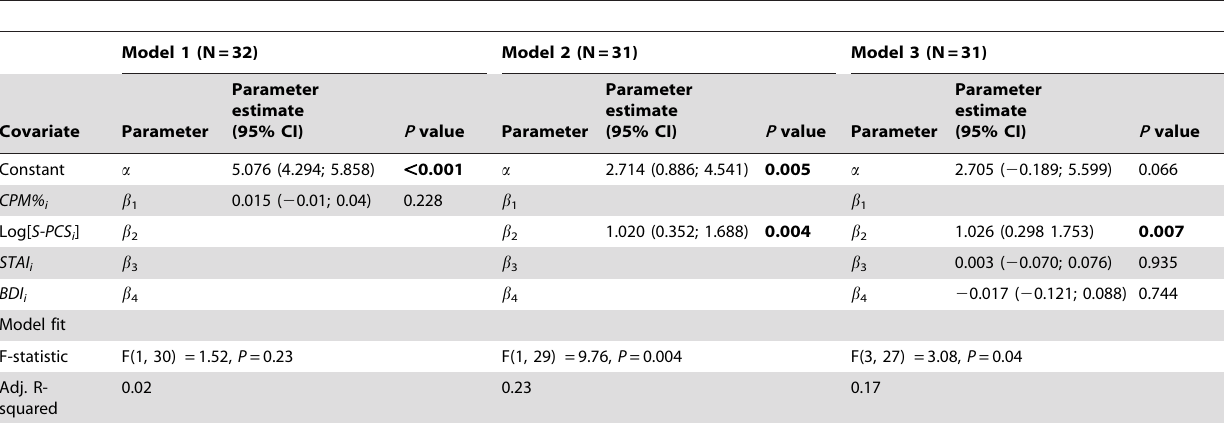
Table 3. Parameter Estimates from Regression Models of Postoperative Movement-evoked Pain Intensity (NRS 0–10) against Preoperative Conditioned Pain Modulation, Situational Pain Catastrophizing, Anxiety, and Depression.